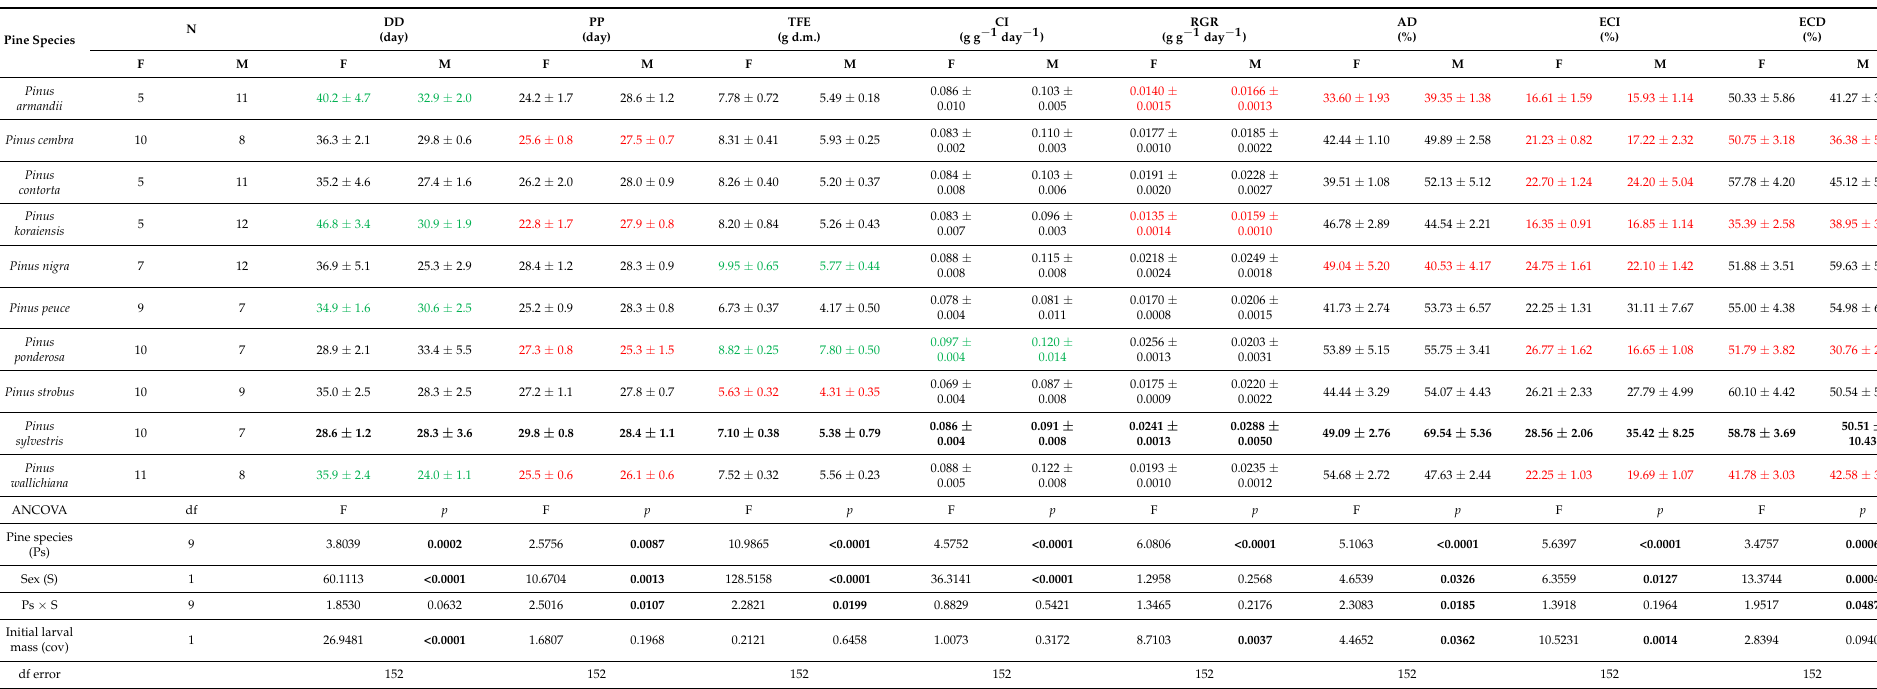
Table A2. Means and standard errors ( ± SE) of various growth-developmental parameters for individuals of the pine lappet ( Dendrolimus pini L.) fed with needles of different pine species. A two-way covariance analysis was used to present the effects of the pine species (Ps) and sex and their interactions. The initial larval mass, i.e., the body mass of the larvae on the starting day of the experiment, was used as covariant. Statistically significant differences p < 0.05 are marked in bold. Mean values marked in red mean that they are significantly lower than the value for the individuals fed with primal host Pinus sylvestris L. needles (bolded; Dunnett’s test used here; α = 0.05), green values indicate higher ones, and black—non-significant differences. The Dunnett’s test was performed for the Ps factor, so there was no sex differentiation, thus two cells (for female and male) are marked in